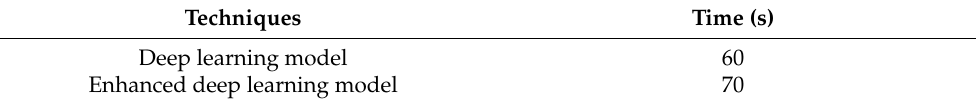
Table 2. Proposed system performance evaluation based on processing time on the ISBI